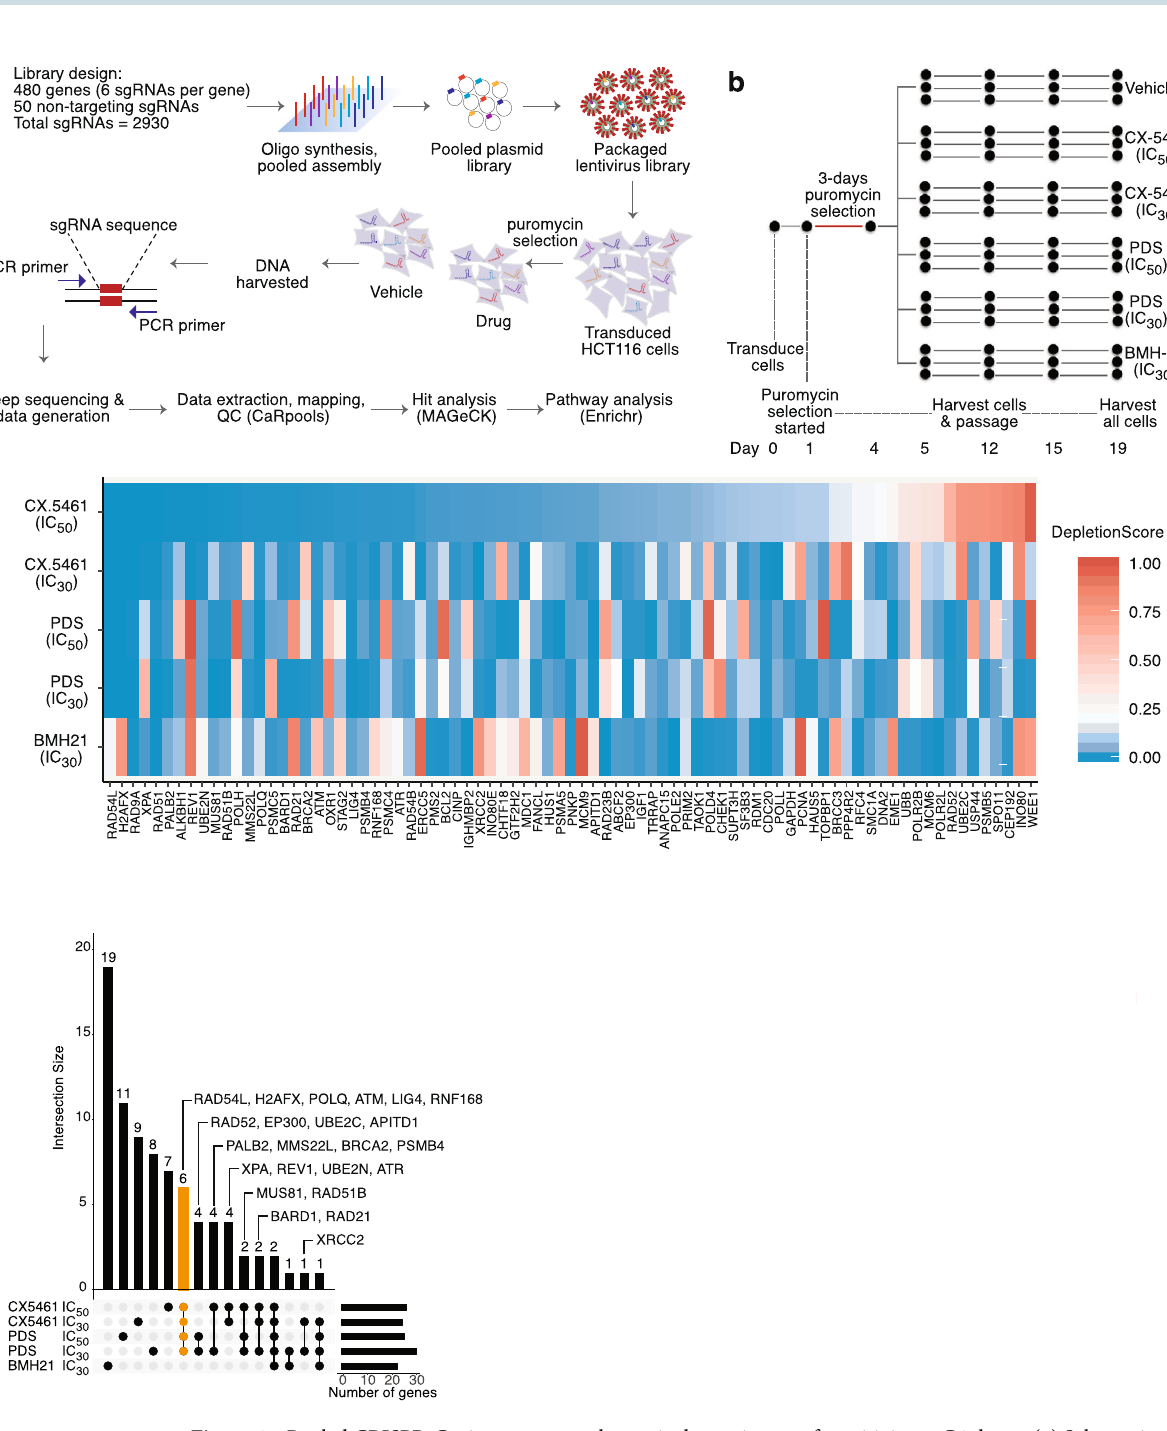
Figure 1. Pooled CRISPR-Cas9 screens reveal genetic determinants of sensitivity to G4 drugs. ( a ) Schematic of pooled screen. ( b ) Experimental design of drug screens. HCT116 cells were transfected with the LCV2-puro library at an MOI of 0.3. After 24 h, 0.5 µg/ml puromycin was added and the cells kept in puromycin for 3 days. On day 5 drug/vehicle treatments were started in triplicate and continued until day 19. Cells were passaged with freshly added vehicle or drugs, and harvested on days 1, 4, 5, 12, 15 and 19 to make DNA for the downstream sequencing library preparation. ( c ) Top 81 depleted genes from MAGeCK output. Each row represents the corresponding drug treatment groups. Heatmap shows the MAGeCK depletion scores of the genes. The heatmap is ordered according to the depletion scores of CX-5461 (IC 50 ) group, ranking the most depleted genes on the left. To emphasize genes with the highest depletion score, the median of the color gradient (white) was shifted to 0.2. ( d ) UpSet plot showing the intersection of candidate genes undergoing negative selection with G4 stabilizers (MAGeCK P -values < 0.045) within each drug condition. In the bottom matrix, each row represents the set of genes identified for the indicated drug condition, and each column represents the intersection of the drug condition gene sets indicated by black dots. The histogram to the right of the matrix indicates the number of genes identified for each input drug condition. The histogram on the top shows the number of genes in each intersection set. Gene hits common in all CX-5461 and PDS conditions are shown in